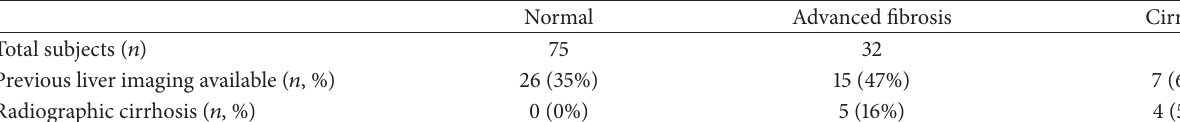
Table 3: Correlation of FibroScan results with retrospective, incidental liver imaging studies. Normal Advanced fibrosis